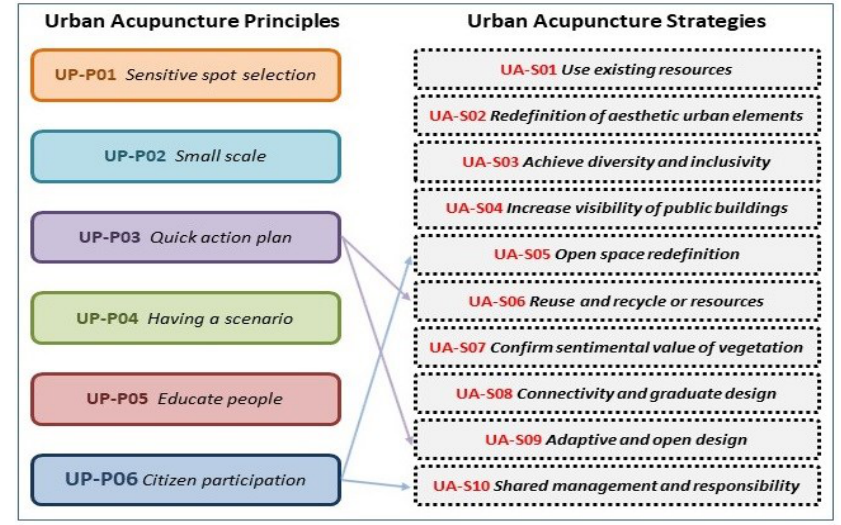
Figure 3. Urban Acupuncture Principles vs